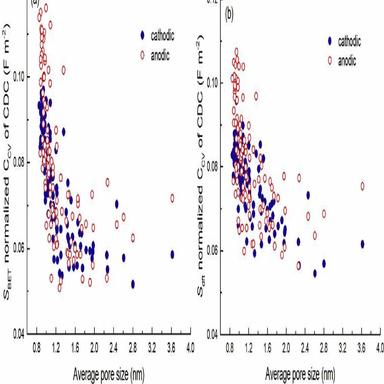
Experimental values vs. predicted gravimetric capacitance (a) and model diagnostic plot (b) corresponding to Eq..